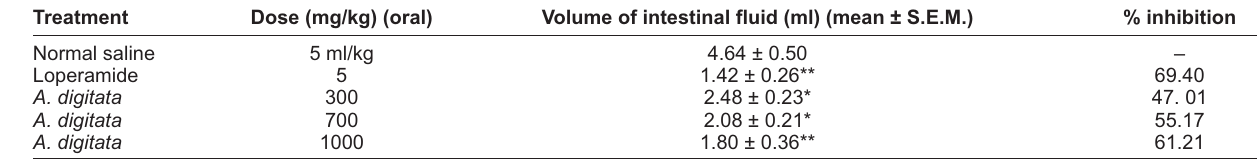
Table-2: Effect of the extract of